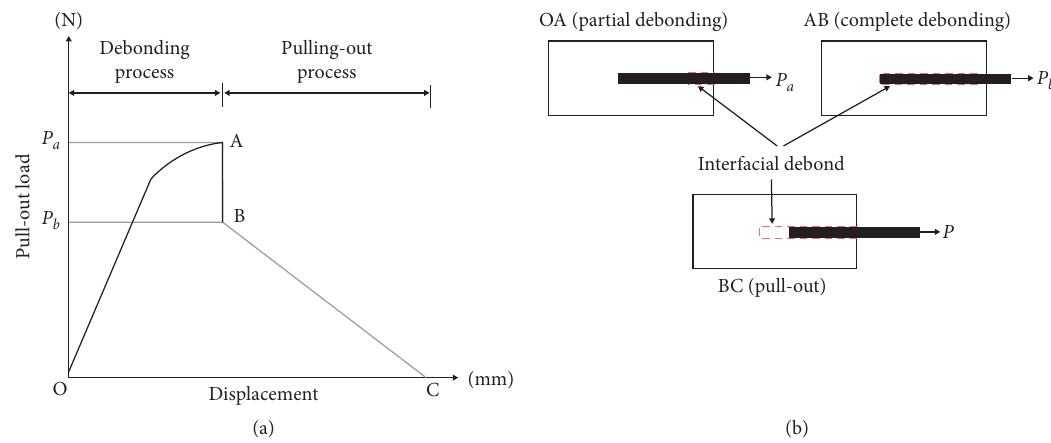
Figure 4: Schematic of typical pull-out load-displacement curves and associated post-pull-out mechanisms.